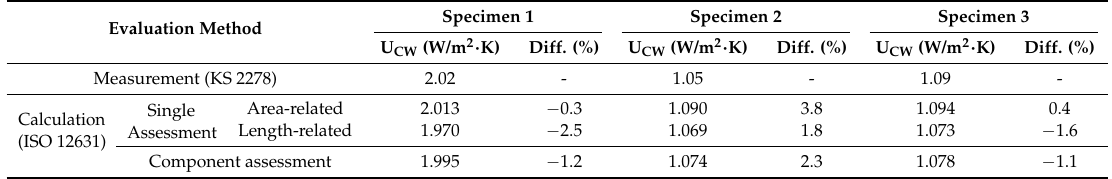
Table 4. Comparison of measured and calculated thermal transmittances of test